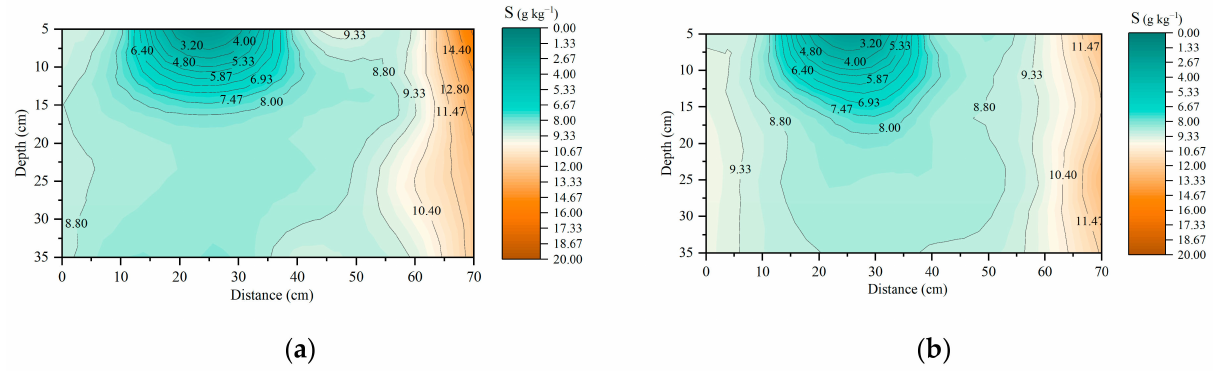
Figure 9. Measured 2D distribution of soil salinity at the end of experiment: ( a ) Measured distribution under W1; ( b ) under W2.